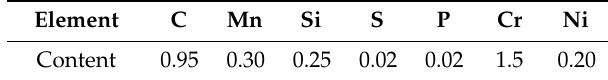
Table 1. Composition of bearing steel. Table 2. Mechanical properties of GCr15 bearing steel. Table 2. Mechanical properties of GCr15 bearing steel.